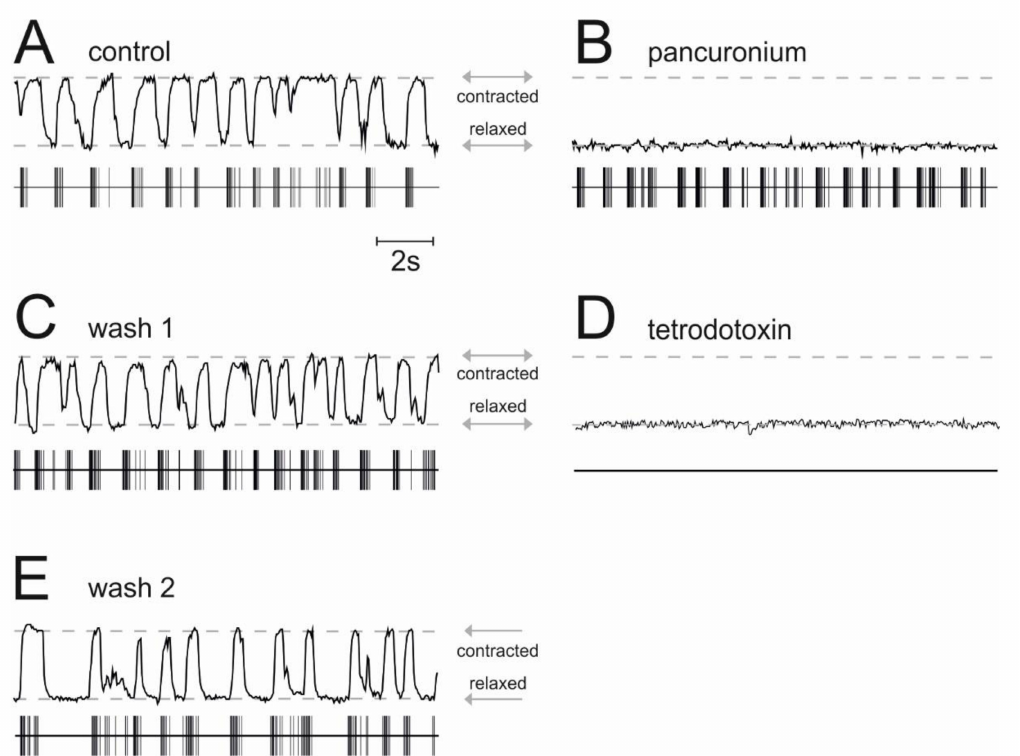
Figure 4. Simultaneous recording of muscle contractions and action potential firing in spinal nerve and muscle co-cultures. The status of the muscle fibers of the nerve and muscle co-culture is given in each figure in the upper half (contracted: line is up, relaxed: line is down), whereas the corresponding neuronal action potential activity is given in the lower half (horizontal line represents baseline noise, each vertical deflection is a single or group of action potentials). ( A ) Control condition in the absence of drugs. Note that there is a correlation between the neuronal activity and the contraction of muscle fibers. ( B ) In the presence of the muscle relaxant pancuronium (1 µ M) the muscle activity is down (i.e., relaxed), whereas neuronal activity remains relatively unchanged. ( C ) After the washout of pancuronium, the regained muscle activity is clearly visible. ( D ) Tetrodotoxin (0.5 µ M) does not induce any neuronal activity, thus, there is no contraction in the muscle fibers. ( E ) After the washout of tetrodotoxin, neuronal and muscular activity is regained, at least to some extent. Note that there is still a correlation between the neuronal activity and the contraction in the muscle